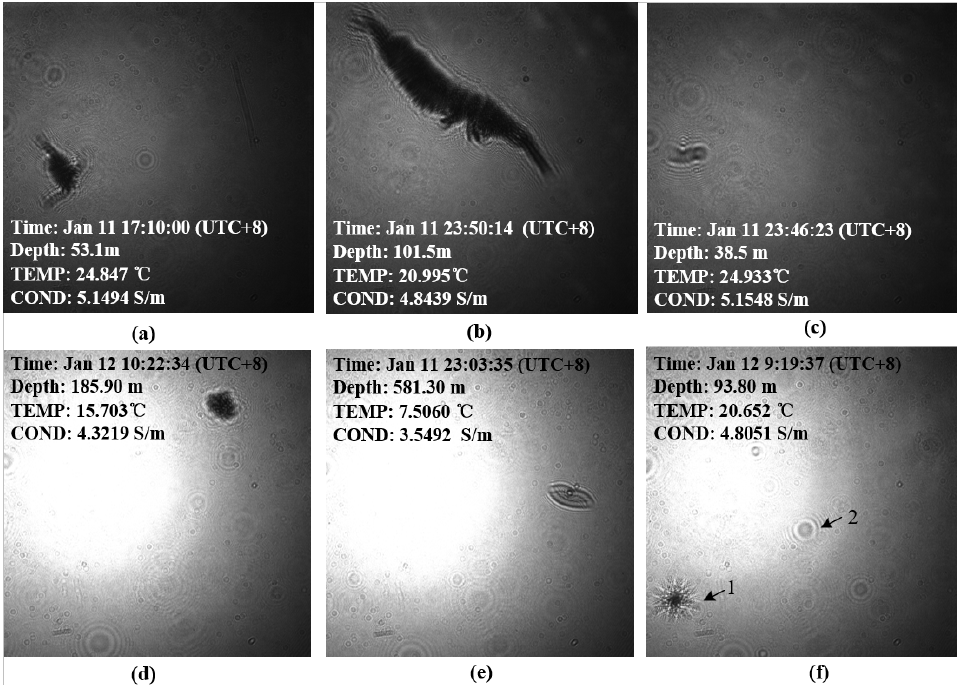
Figure 4. The samples of plankton hologram images, captured in the South China Sea, annotating the time, depth, temperature, and conductivity when the hologram was taken. The intensity of the hologram was highly associated with the variations in temperature and ambient light (time is local time UTC+8 h). ( a ) Copepoda , ( b ) Euphausiid , ( c ) Oikopleura , ( d ) Marina Snow , ( e ) Coelodendridae , ( f ) Acantharian (1), Copepoda (2).